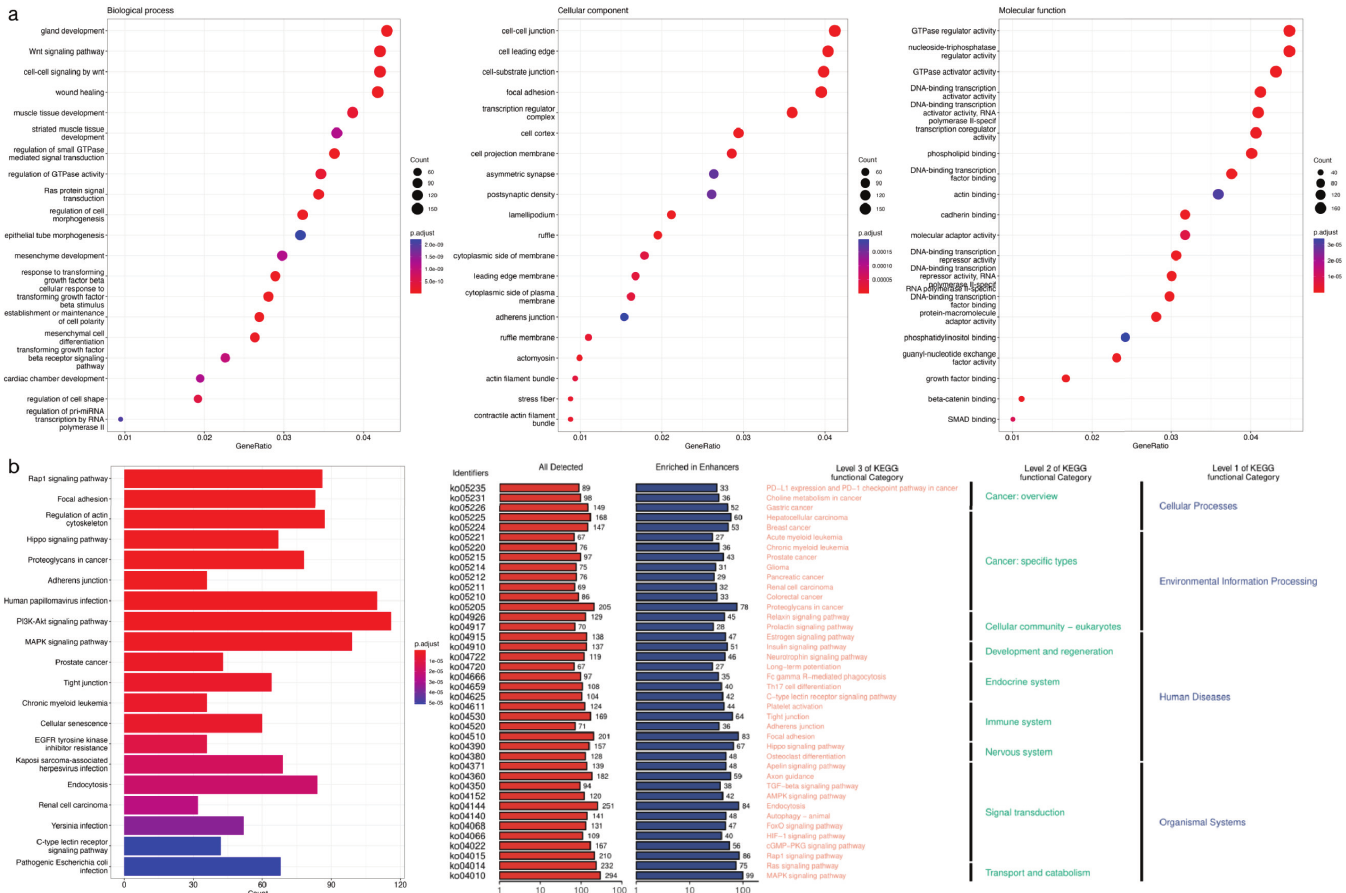
Fig 11. Genomic enrichment analysis of placental enhancers identified by SMFM. (a) The top 20 categories of gene ontology (GO) analysis ordered by p -values, including biological process, cellular component, molecular function. (b) shows the top 20 KEGG enrichment pathways ordered by p -values and KEGG classified by different functional category levels of